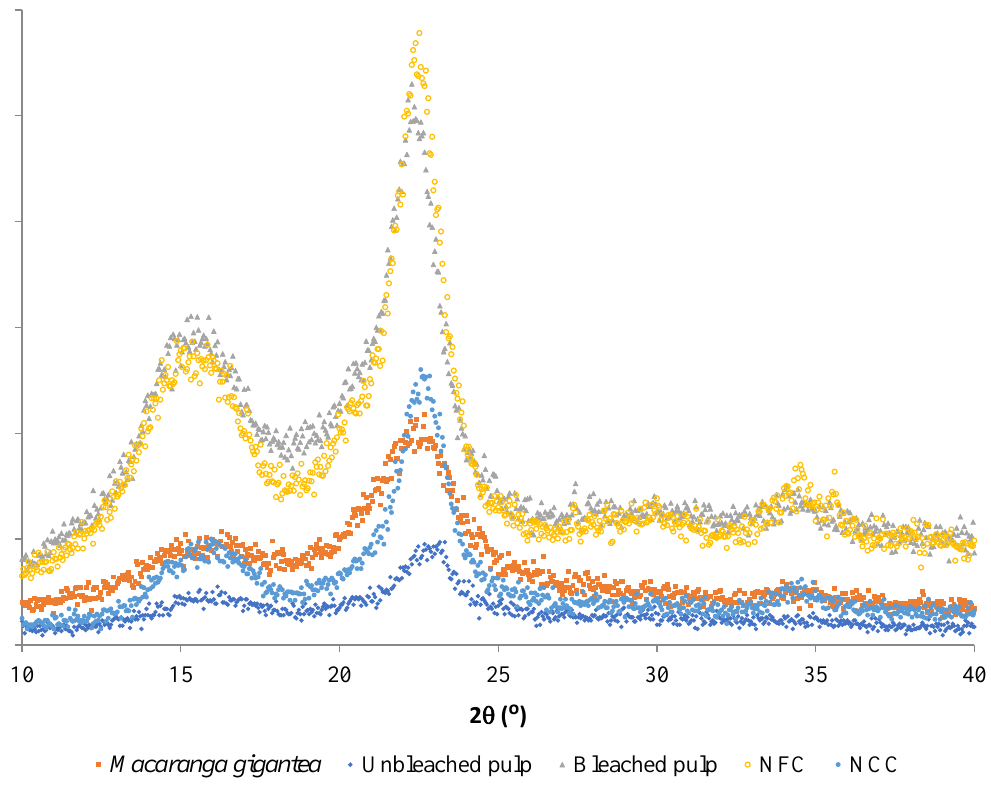
Figure 5. XRD graphs from every processing stage. raw material Macaranga to nanocellulose. The thermal behavior properties of all samples were evaluated via thermogravimet- ric analysis. Looking at the thermogram for all the samples, they displayed the same shape except for NCC (Figure 6). It was observed that the wood chips seemed to decompose faster in the initial stage than the rest of the samples. The initial weight loss between 40 and 100 °C is due to water evaporation and moisture removal in the sample material [30]. The second phase of decomposition starts at approximately 200 °C and continues until approximately 380 °C, which is ascribed to the decomposition of hemicellulose and cellu- lose. Cellulose decomposition generally starts at 270 °C for all the samples except NCC. In the case of NCC, cellulose decomposition starts at 200 °C, followed by a second decom- position between 310 and 490 °C. The lower thermal stability of NCC compared to the rest of the samples is due to the presence of sulfate groups on the surface of NCC, which makes the decomposition much faster. If protonated, the sulfate groups are protic acids that can catalyze degradation, whereas if unprotonated, they undergo elimination reactions that can also lead to a reduction in thermal stability [31].